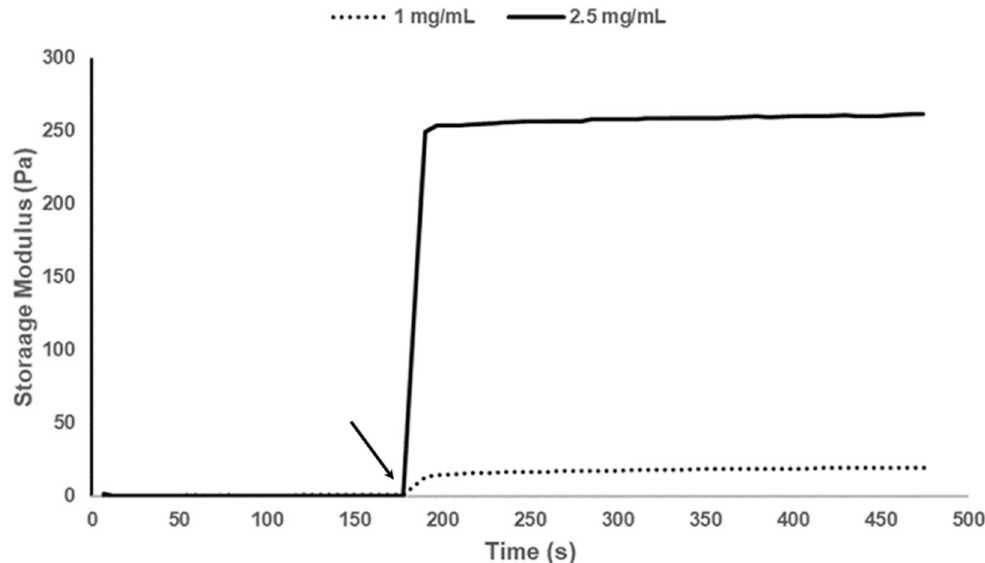
Figure 5. Storage moduli of both 2.5 mg/mL and 1 mg/mL methacrylated collagen in the presence of 0.1% LAP cross-linker. The arrow indicates the point at which the UV light was switched on. The samples were irradiated at 12 mW/cm 2 for 12 s.